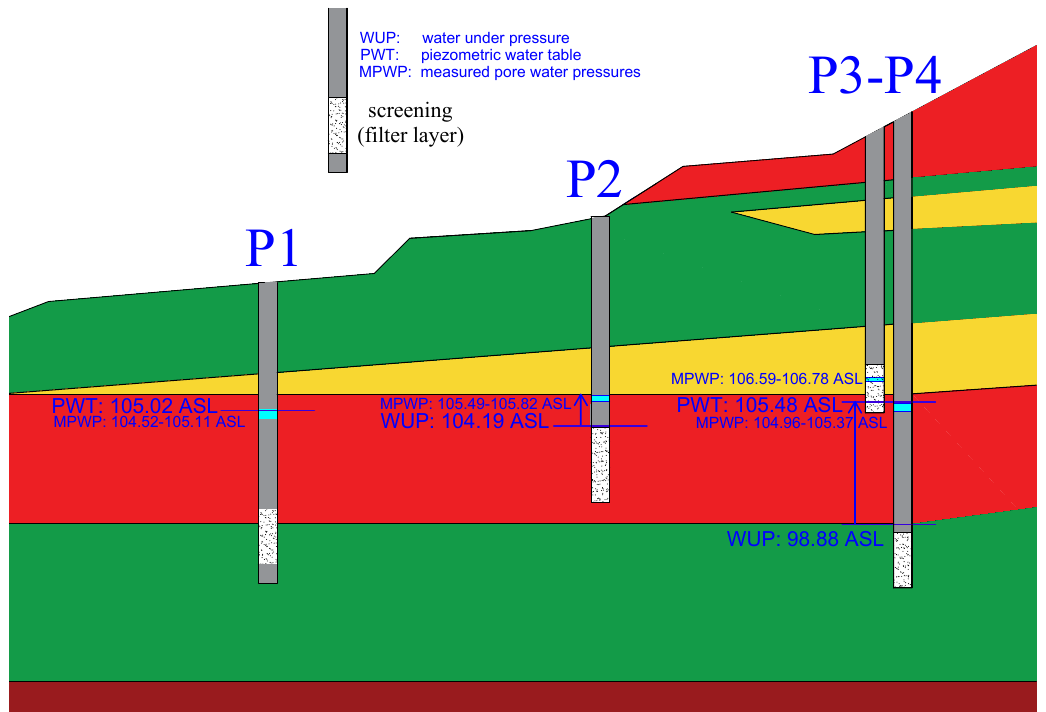
Figure 5. Casagrande piezometers (P1–P4) with measured water levels (legend: WUP—water under pressure, i.e., the level where water was first detected at the time of drilling; PWT—piezometric water table; and MPWP—measured pore water pressures).